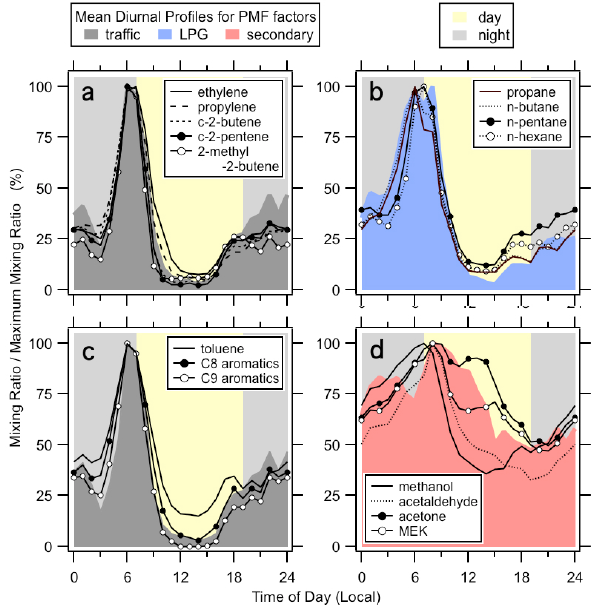
Figure 5. Measured VOC profiles as a function of local time (UTC - 6 hours) normalized to the 1005 Fig. 5. Measured VOC profiles as a function of local time maximum of the mean mixing ratio for individual compounds within chemical families: alkenes (a), 1006 (UTC – 6h) normalized to the maximum of the mean mixing ra- alkanes (b), aromatics (c) and OVOCs (d). Normalized mean profiles for PMF factors (FPEAK=0) 1007 tio for individual compounds within chemical families: alkenes (a) , are shown as shaded areas for each chemical family. 1008 alkanes (b) , aromatics (c) and OVOCs (d) . Normalized mean pro- files for PMF factors (FPEAK 0) are shown as shaded areas for each chemical